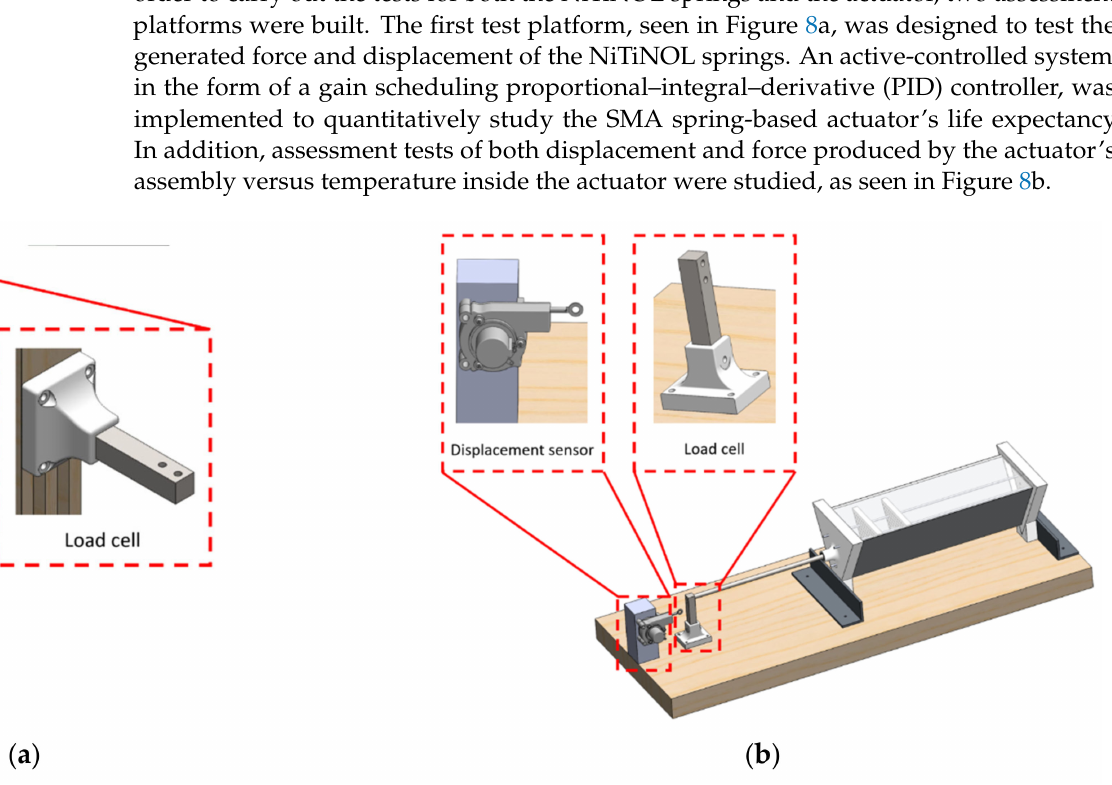
Figure 8. Mechanical models of the assessment platforms for the ( a ) SMA spring, and ( b ) actuator’s assembly